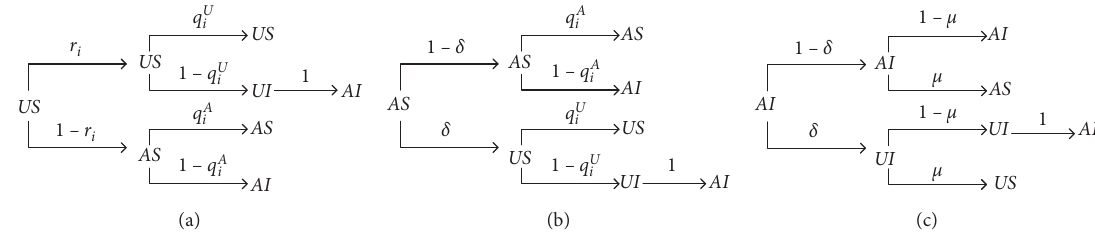
Figure 3: Probability trees for the transition for the possible states at each time step for the model. The four possible states are aware-infected ( AI ), aware-susceptible ( AS ), unaware-infected ( UI ), and unaware-susceptible ( US ). The transition probabilities are r i from U to A , q A i from S to I if node i is aware, q U i from S to I if node i is unaware, δ from A to U , and μ from I to S